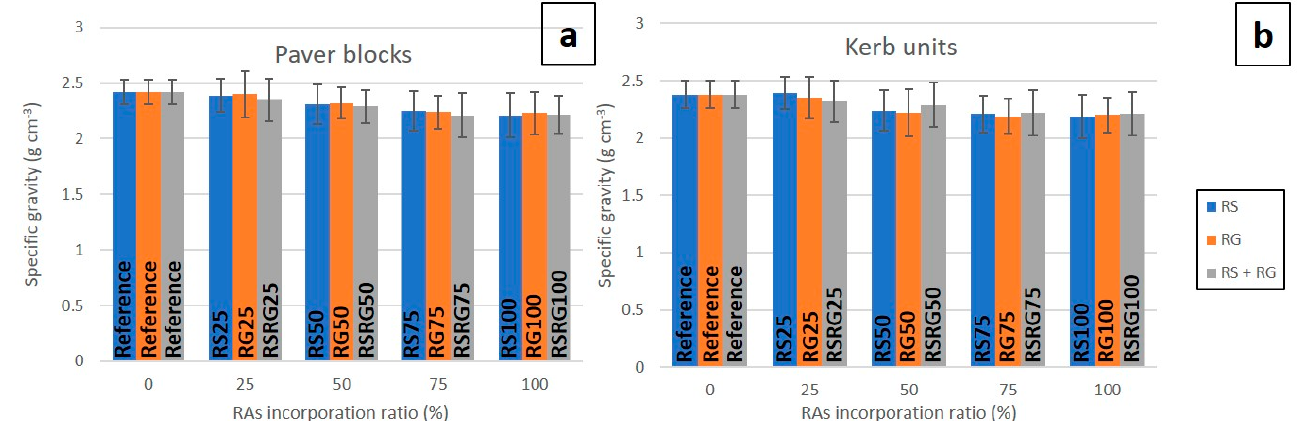
Figure 5. Graphical representation of specific gravity vs. RAs’ incorporation ratio in pavers ( a ) and kerbs ( b ).